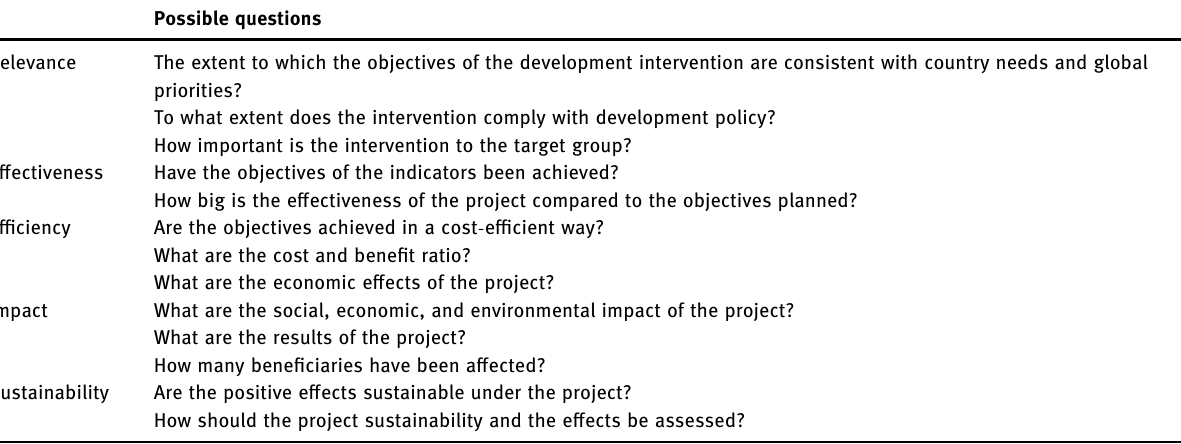
Table 1: Methodology and possible questions Possible